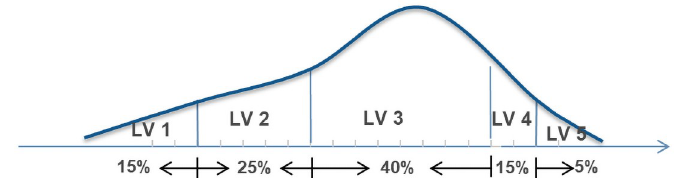
Fig 2. Proportional distribution of the number of rank